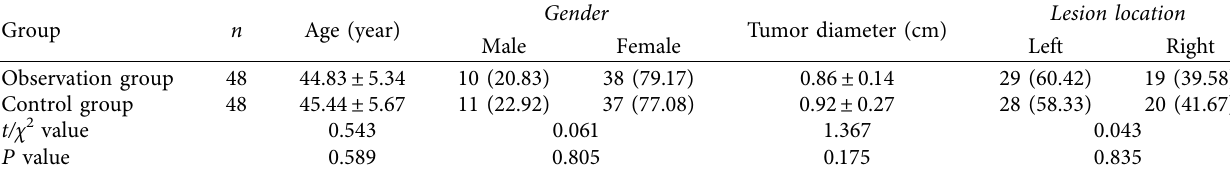
Table 1: Comparison of baseline data between the two groups ( x ± s ; n , %).